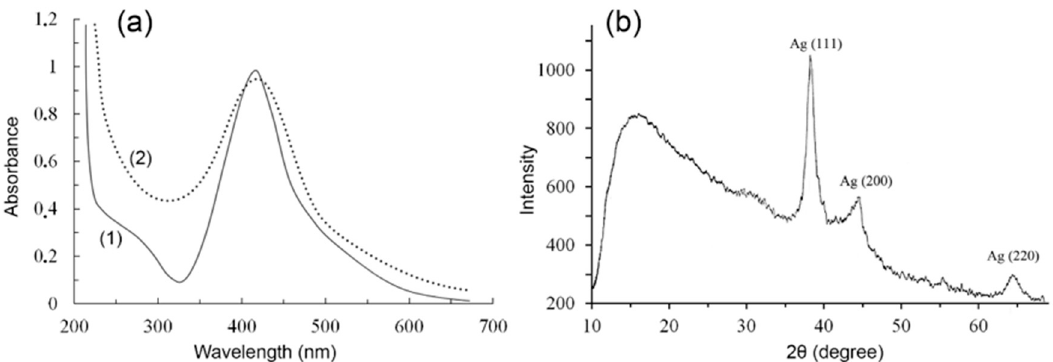
Figure 4. ( a ) UV-visible spectra of AgNPs nanocomposites synthesized using various different reducing agents: NaBH 4 (1) and formaldehyde (2); ( b ) typical X-ray diffraction pattern of AgNPs nanocomposites.